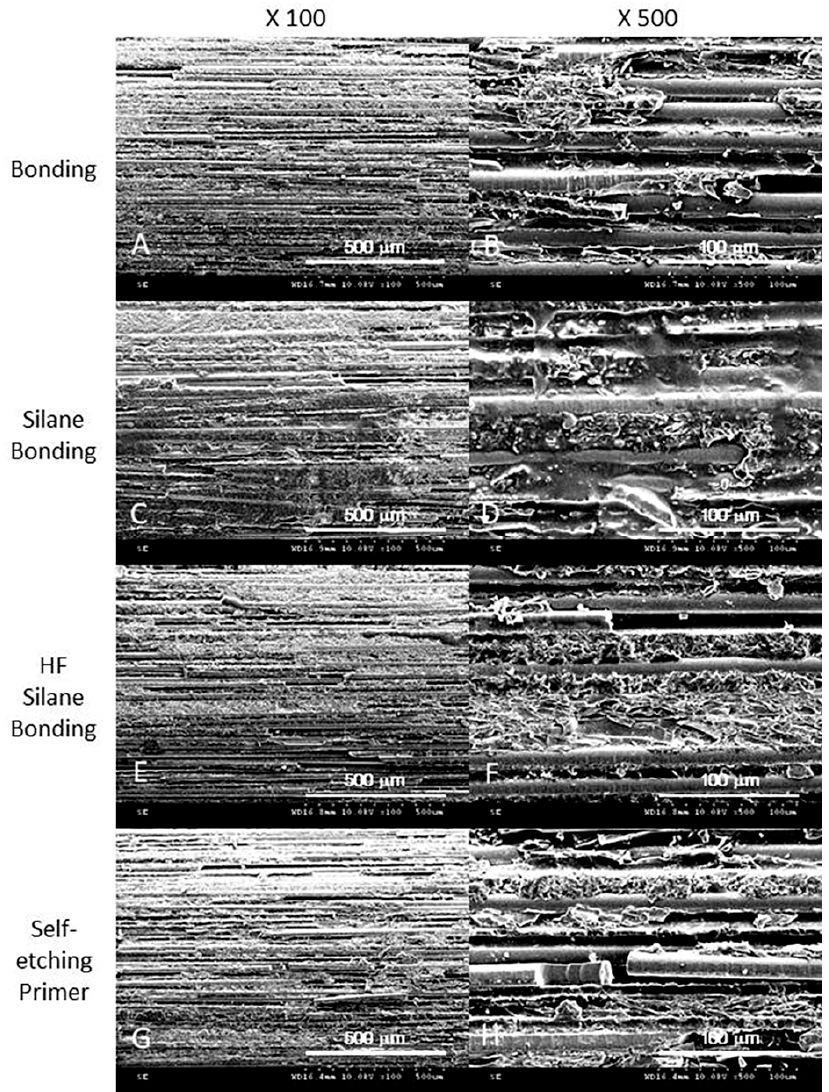
Figure 2. SEM image of the surface of all groups: A and B, dentin bonding group 1; C and D, group 2, silane + dentin bonding treated group; E and F, group 3, HF + silane + dentin bonding treated group; G and H, group 4, self-etching primer treated